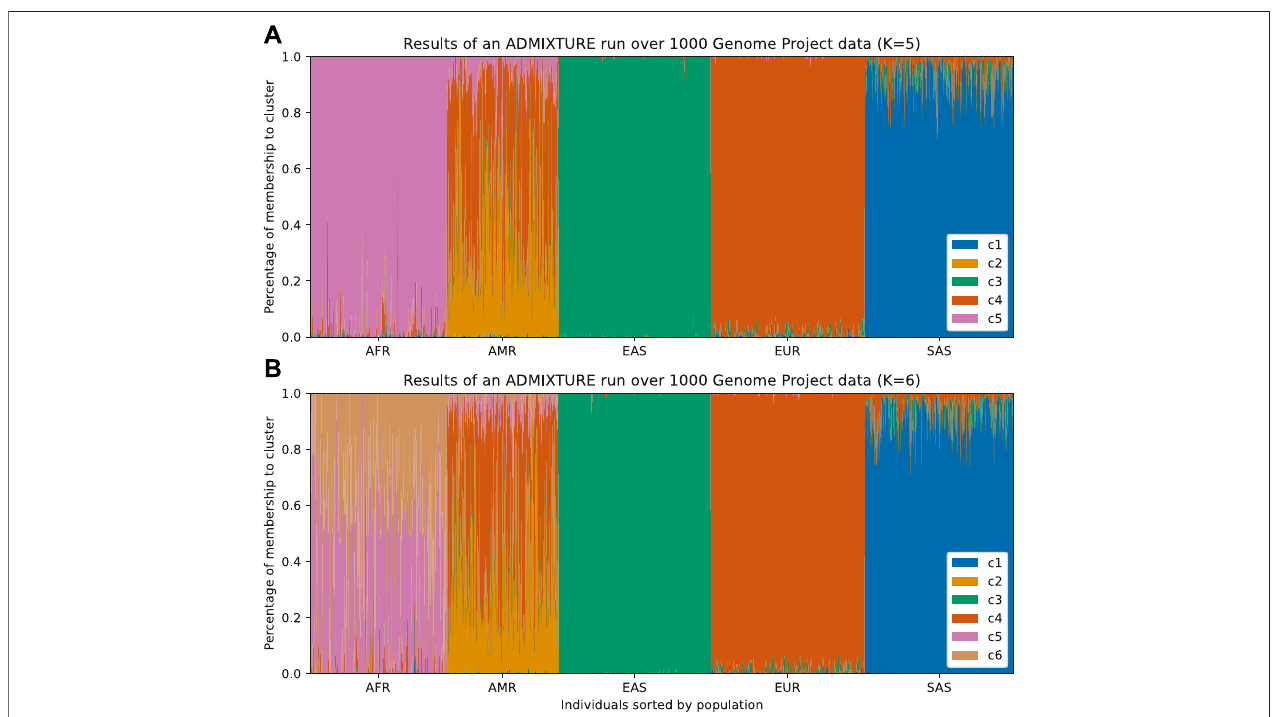
FIGURE 1 | Individuals from 1,000 Genomes Project are plotted according to their labeled self-reported ancestry (AFR, African; AMR, Ad Mixed American; EAS, East Asian;EUR, European;SAS,SouthAsian). (A) ResultsfromanADMIXTUREanalysiswithK (cid:1) 5(numberofclusters).Thecolorsrepresenttheclustersinferred from the data. In this fi gure, we can infer that c1 corresponds to South Asian ancestry, c3 to East Asian ancestry, c4 to European ancestry, and c5 to African ancestry. The Admixed American population appears as the most varied across clusters and has an exclusive cluster (c2), which suggests that there is a mix of native ancestry and in fl ux fromAfrica and Europe. (B) By running ADMIXTUREwith K (cid:1) 6wecanappreciate similarresults.The extraclusterindicatesfurtherstructure withintheAfrican population, which could be either from admixture or the existence of subpopulations in the African samples, but the rest remains